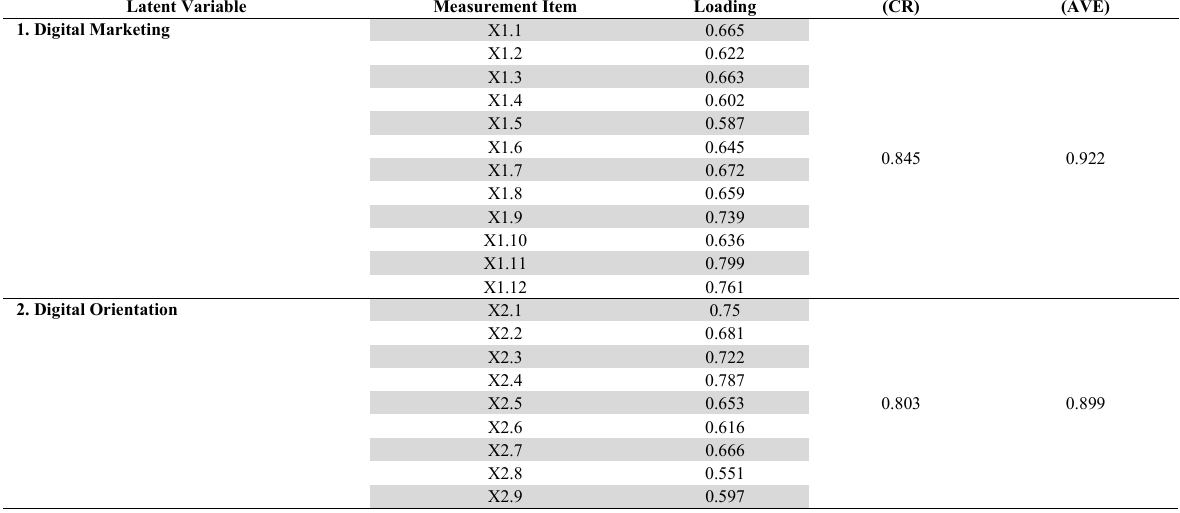
Convergent validity results Latent